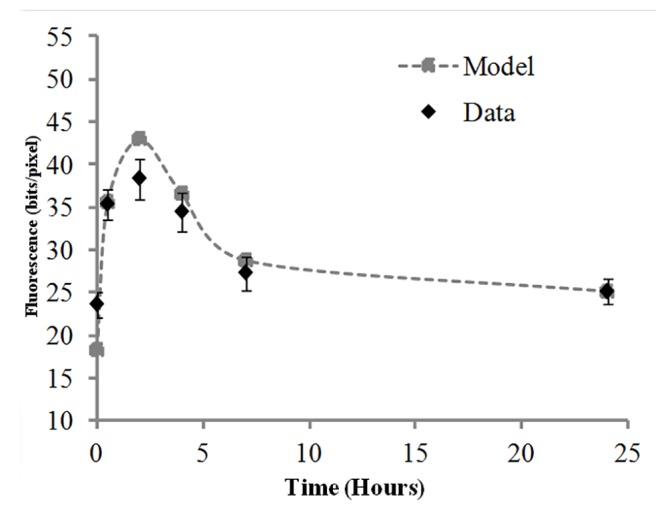
Donor γ-H2AX yields repair kinetics.Experimental data and model fit (from Equation 1) of γ-H2AX yields repair kinetics pooled from 94 donors exposed ex vivo to 4 Gy gamma radiation at 0.5 h, 2 h, 4 h, 7 h and 24 h post irradiation. Error bars represent ± SEM.